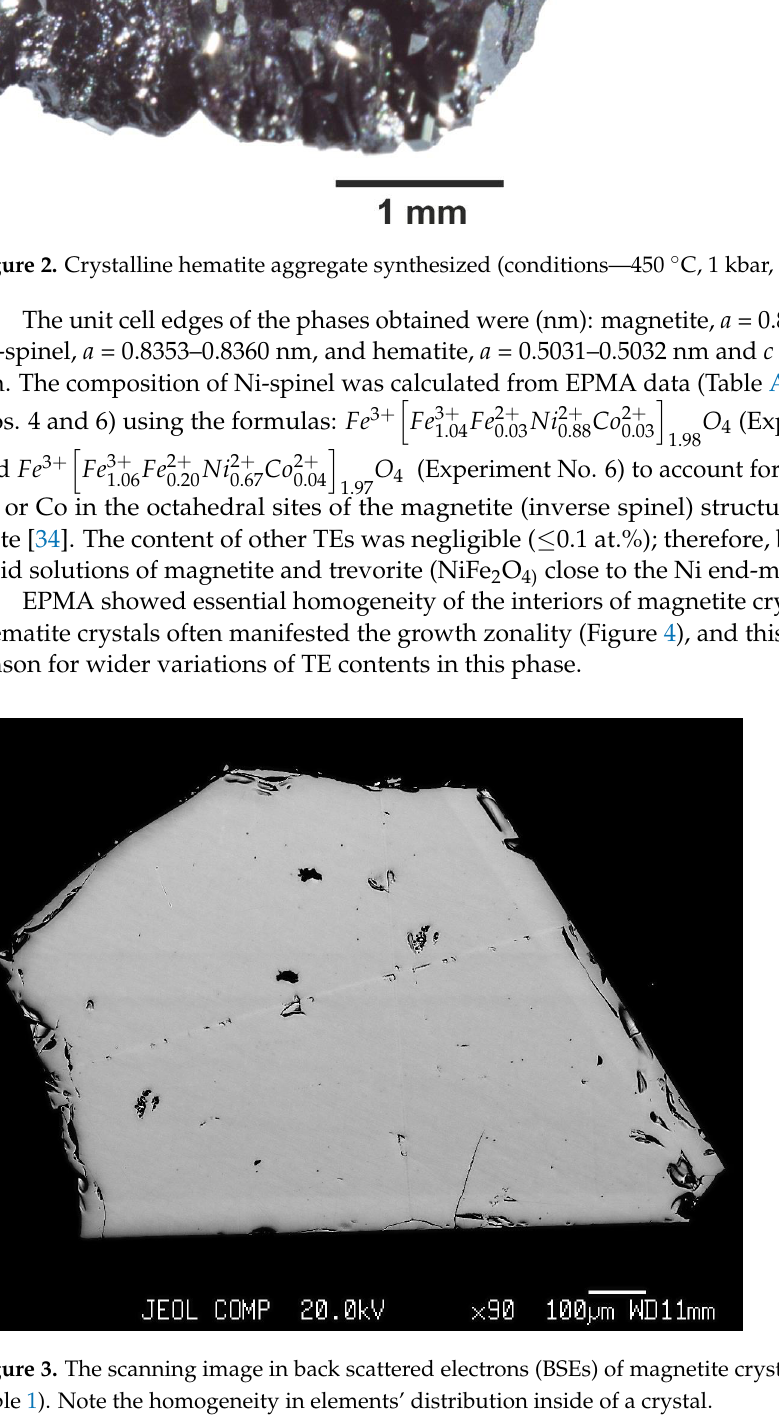
Figure 4. BSE image of hematite and magnetite crystals intergrowth from Experiment 11 (Table 1). Fine growth zoning in hematite crystal is clearly seen.